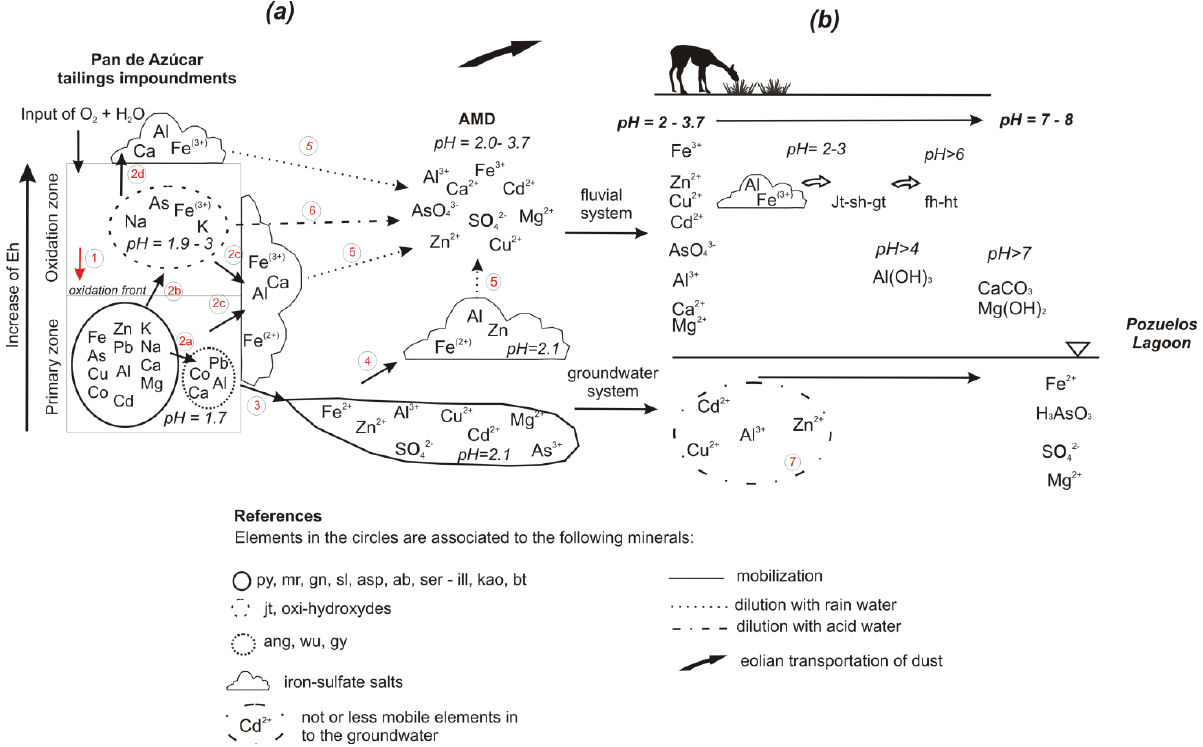
Figure 13. ( a ) Cycle of sulfide oxidation, sulfate formation, and metal mobility at the Pan de Azúcar mine tailings impoundments; and ( b ) Possible pathway of metals from the tailings to the fluvial and ground water systems and then on to Pozuelos